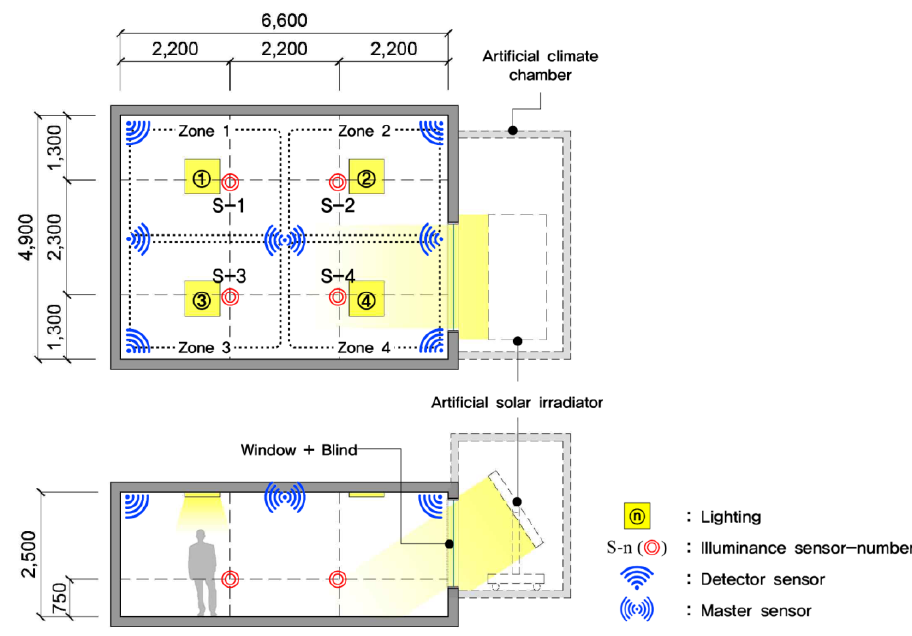
Figure 5. Test bed section, plane, and sensor location.